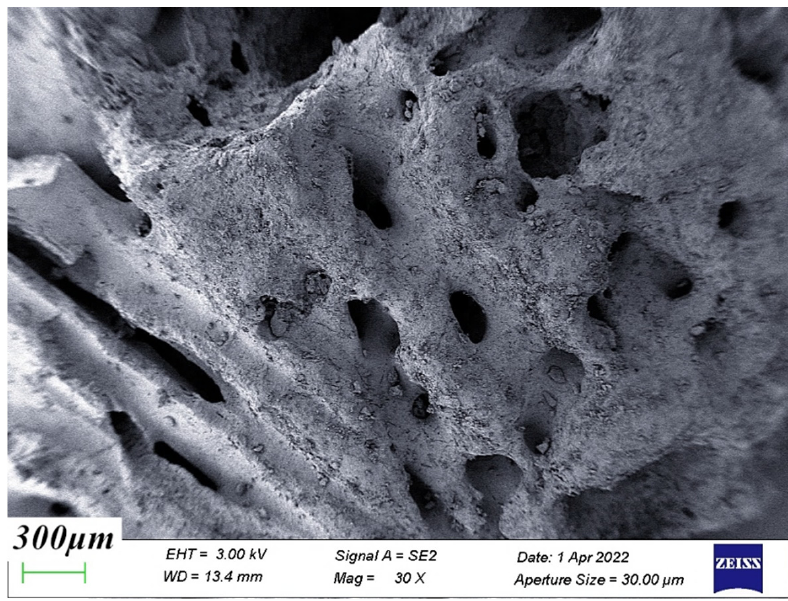
Figure 13. Coral coarse aggregate.